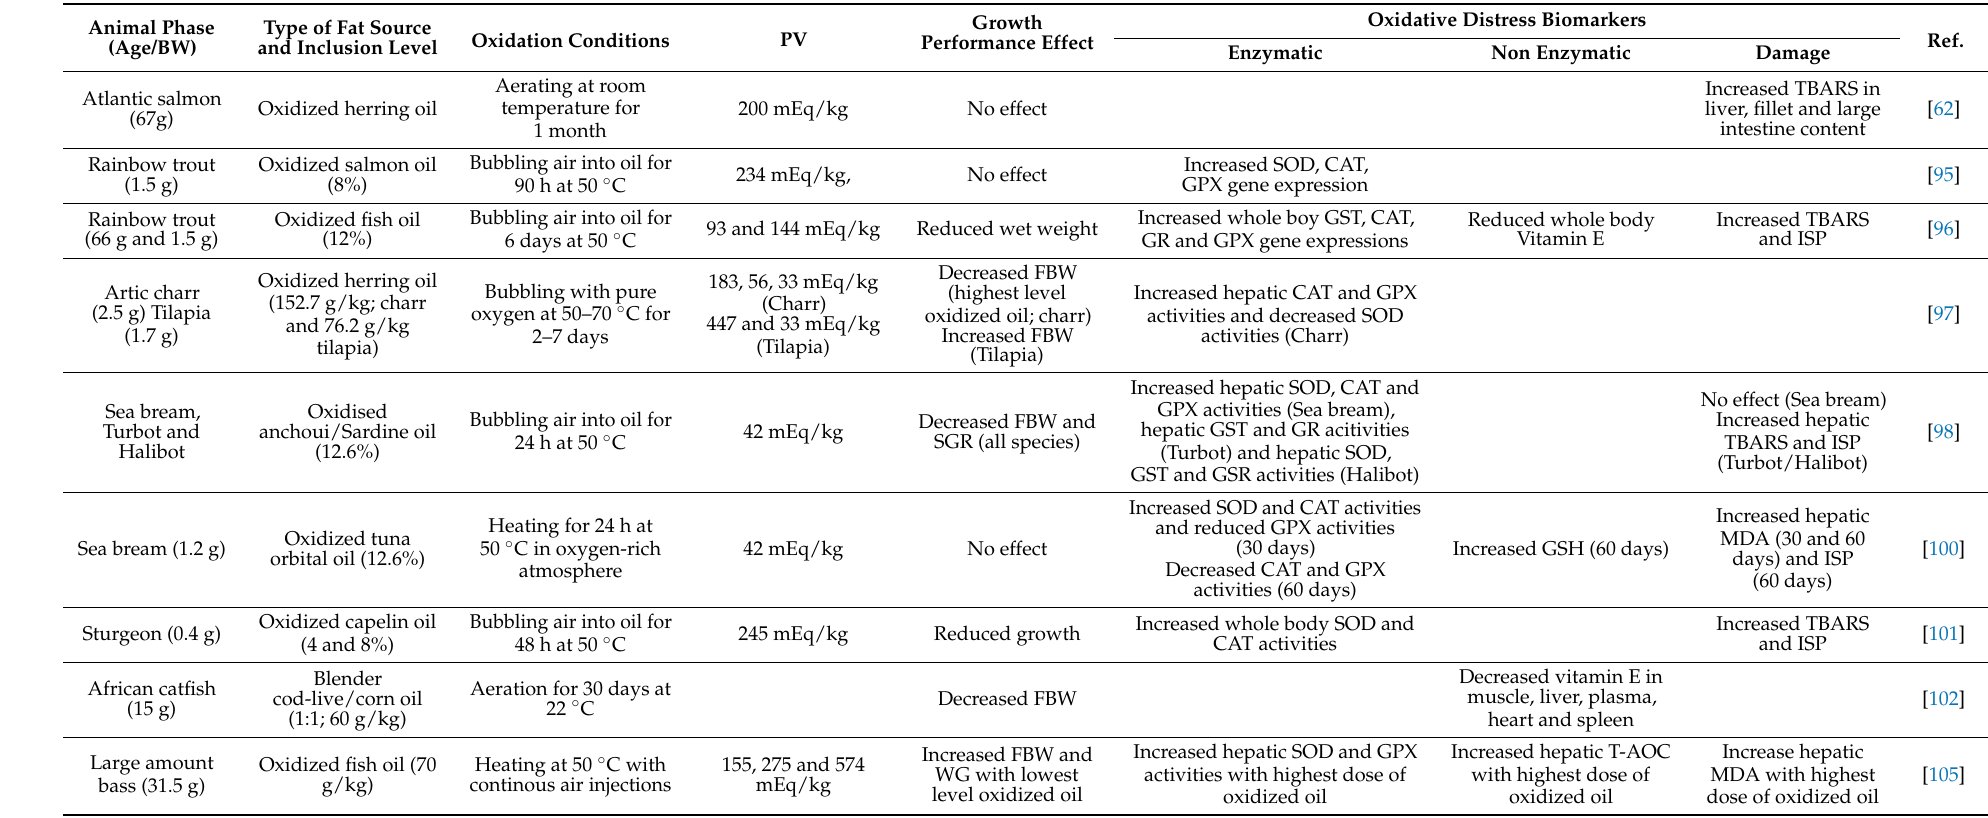
Table 3. Summary of the dietary oxidative challenges models based on oxidized fat discussed within this review in fish, including type of fat, oxidation conditions, resultant fat characterization and inclusion level in feed, and results, including growth performance impact, oxidative stress markers evaluated classified by enzymatic, non-enzymatic or oxidative